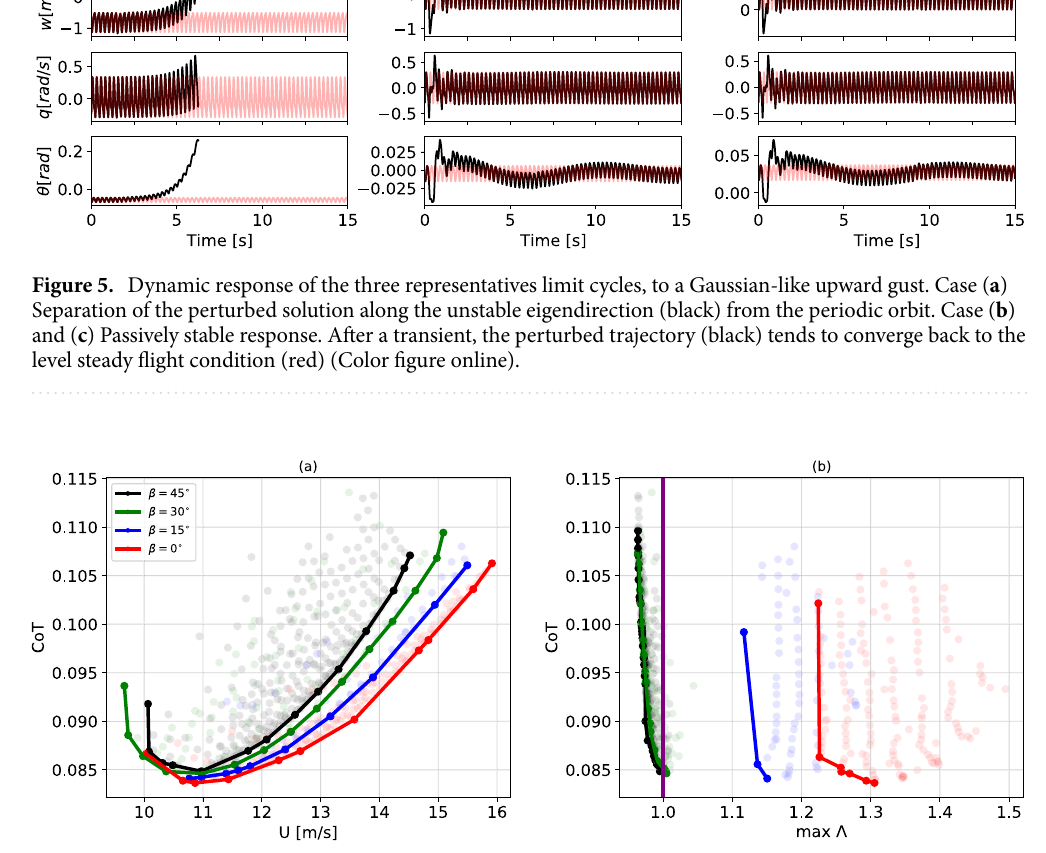
Figure 6. Trade-off between CoT and stability. ( a ) Lower envelope of the CoT as a function of the forward flight velocity of four evenly-spaced β -planes. We report all the possible solutions, from which the lower envelope is extracted, with transparent points, coloured accordingly with the respective tail opening. ( b ) Pareto front of the CoT as a function of the largest Floquet multiplier of four evenly-spaced β -planes. We report all the possible solutions, from which the Pareto front is extracted, with transparent points, coloured accordingly with the respective tail opening. The stability transition is highlighted with the purple vertical line (Color figure